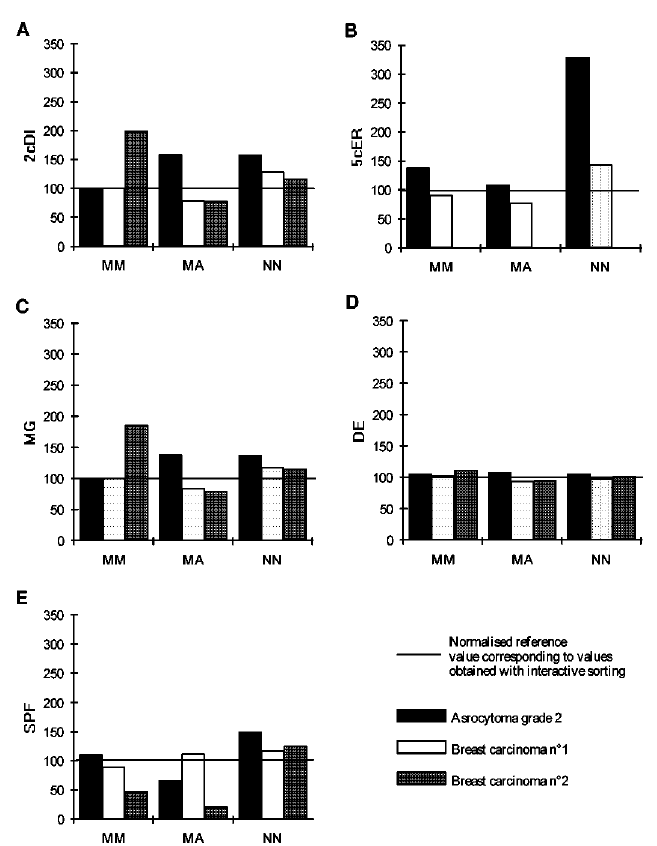
Fig. 2. 2cDI (A), 5cER (B), MG (C), DE (D), SPF (E) normalised values obtained after the elimination of debris and aggregates by each of three automatic methods.